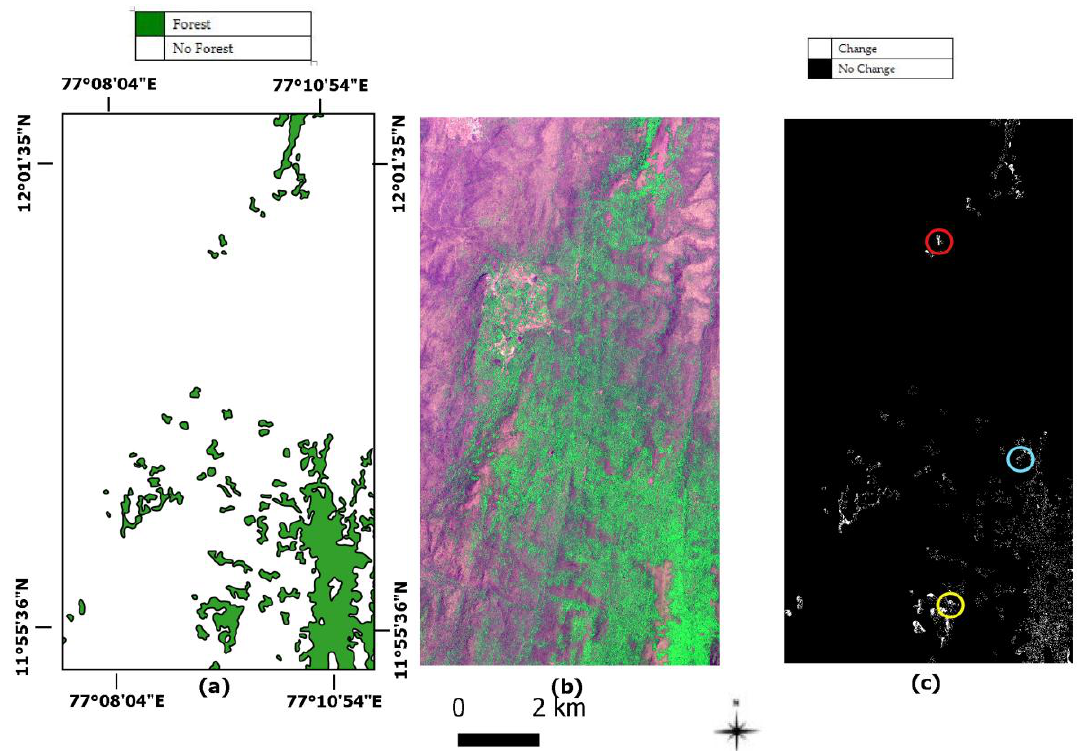
Figure 13 Figure 13. Experiment 2b—CCA_VHR, Indian site: ( a ) evergreen forest layer from vegetation map